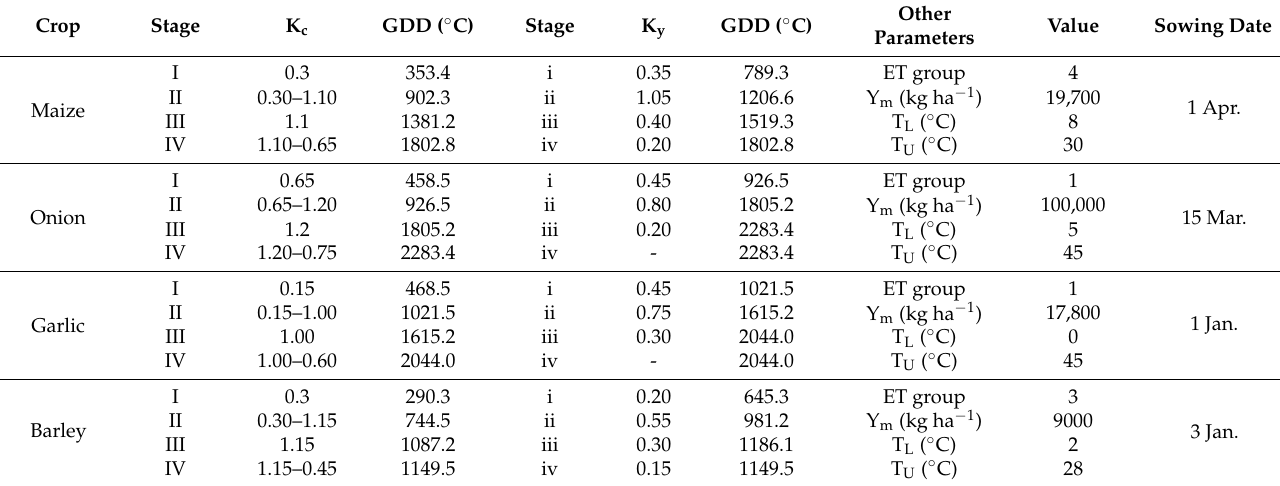
Table 1. Calibrated parameters for MOPECO for the crops studied in